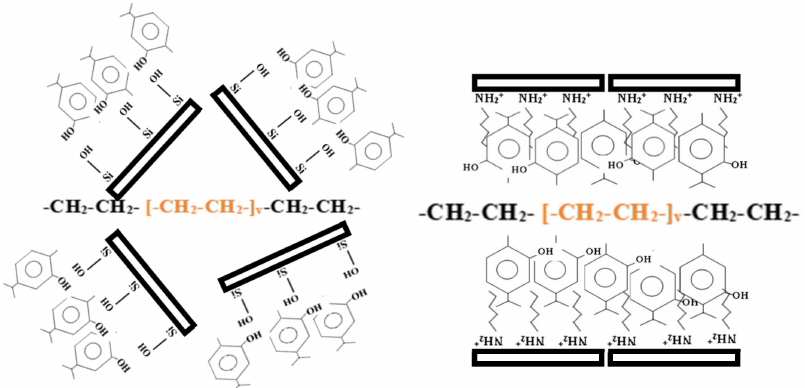
Figure 3. Schematic illustration of the exfoliated structure of LDPENaMtEO samples (left part) and the intercalated structure of LDPEOrgMtEO sample (right